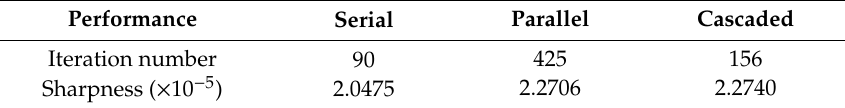
Figure 7. The relationship between iteration number and the sharpness of retrieved amplitudes from the serial, parallel, and the proposed cascaded methods; 1 35 n = , N = 600. Table 1. Reconstructed performance comparison of the three